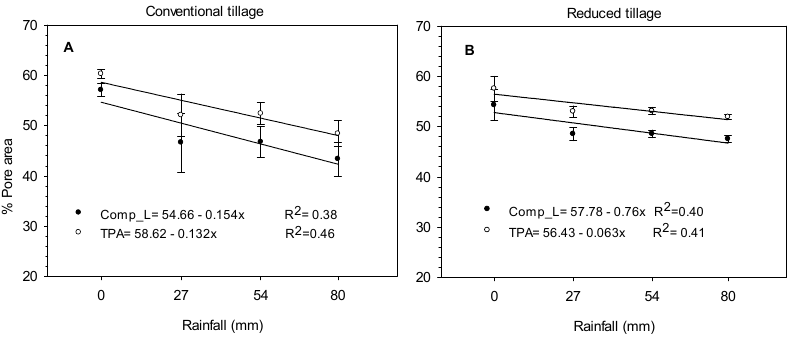
Figure 1. Effect of applied rainfall on percentage of pore area, in conventional ( A ) and reduced tillage ( B ) for layer 1 in 2009 year. Comp_L: complex large; TPA: total pore area. Error bars are standard errors.